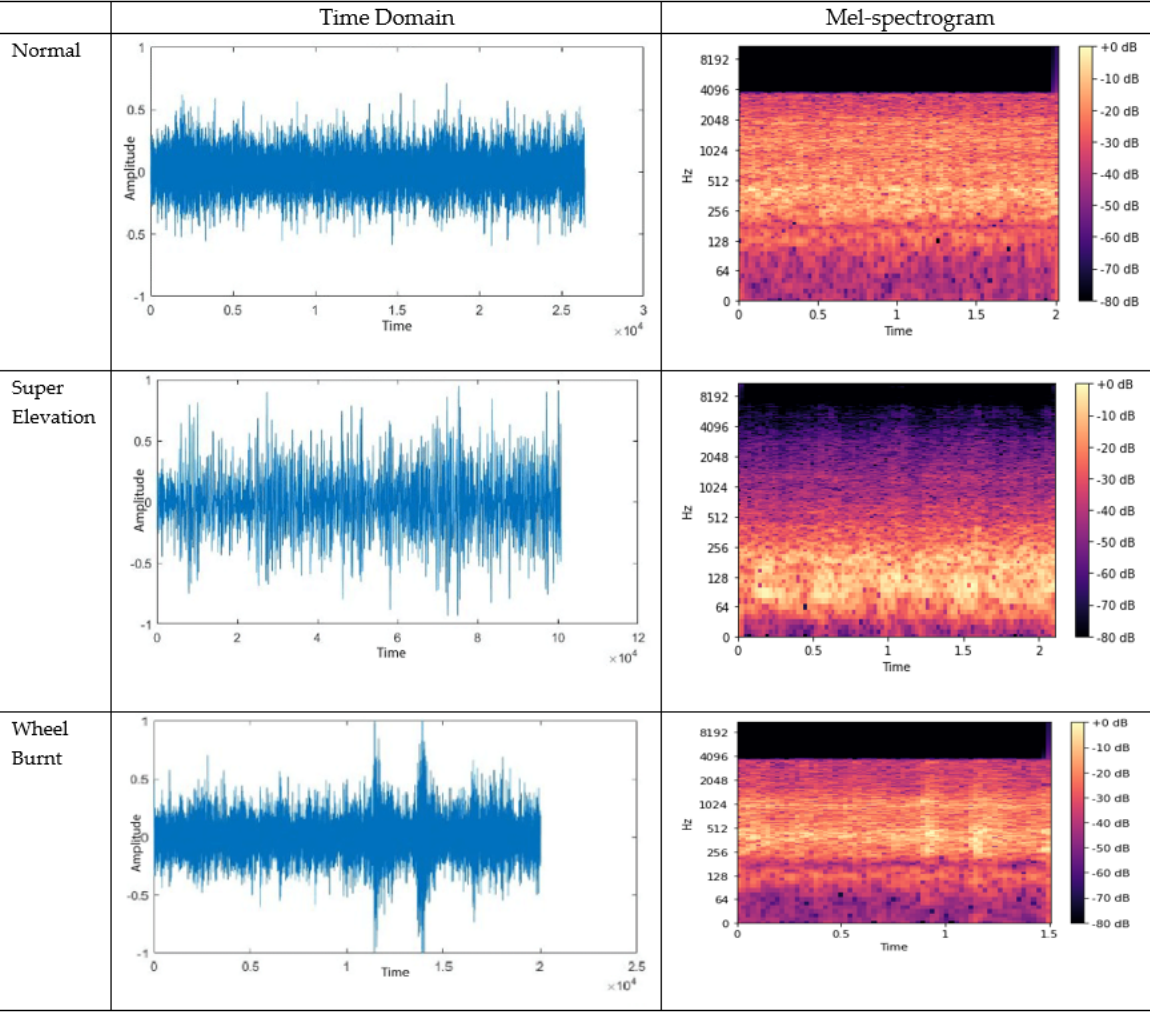
Figure 9. Normal, super elevation and wheel burn signals in time domain and MFCC. Mel-spectrogram shows clear difference in the signals for different